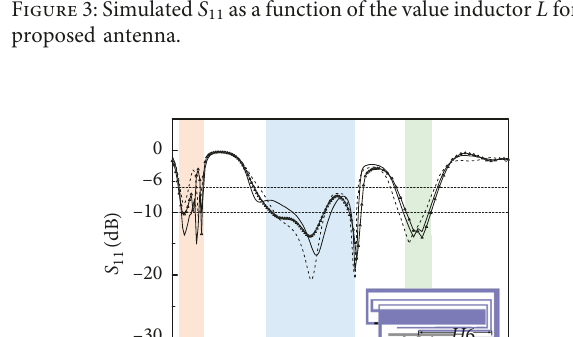
Figure 3: Simulated S 11 as a function of the value inductor L for the proposed antenna.